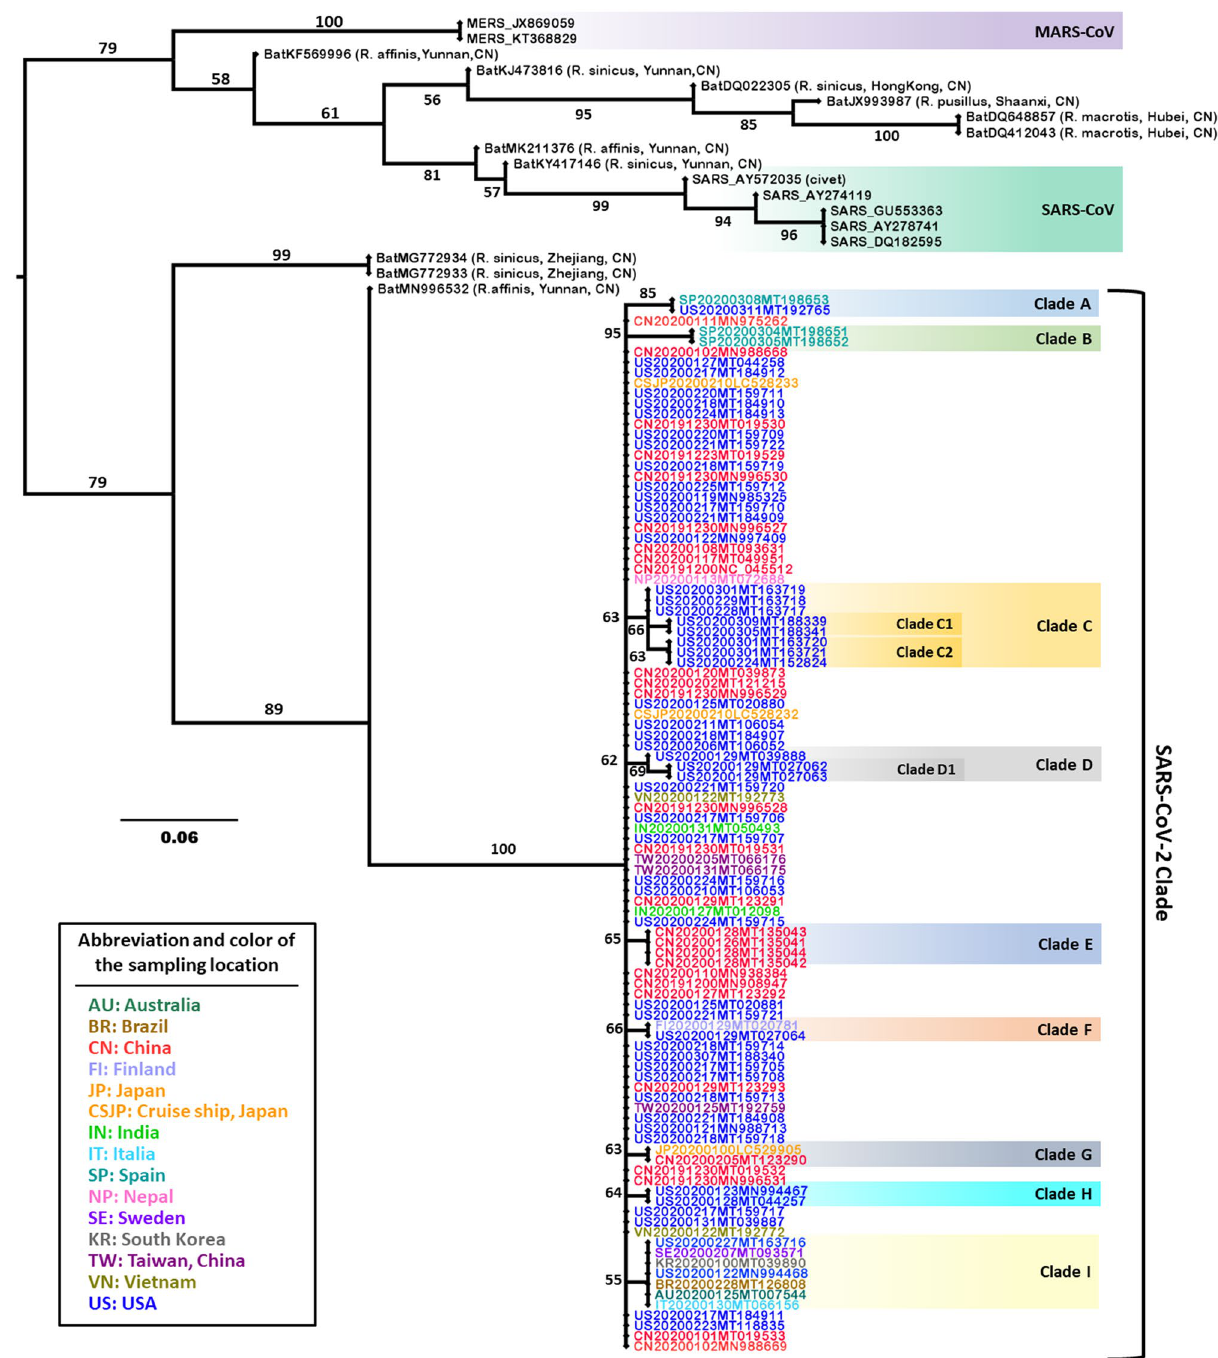
is the combination of the abbreviation of sampling location, sampling time, and Genbank accession. MERS-CoV clade, SARS-CoV clade, and nine clades of SARS-CoV-2 are highlighted and labeled, respectively. The numbers along the branches mark the bootstrap values percentage out of 1000 bootstrap